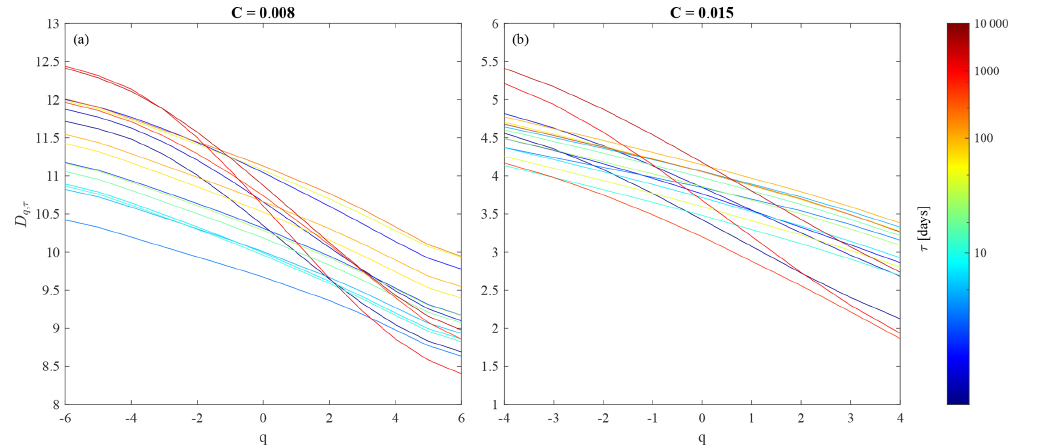
Figure 9. D q,τ spectra for the coupled ocean–atmosphere dynamics at different timescales τ j (indicated by different line colors) for recon- structions of MIMFs as in Eq. (12) ( D q,τ ) for (a) C = 0 . 008 and (b) C = 0 . 015.